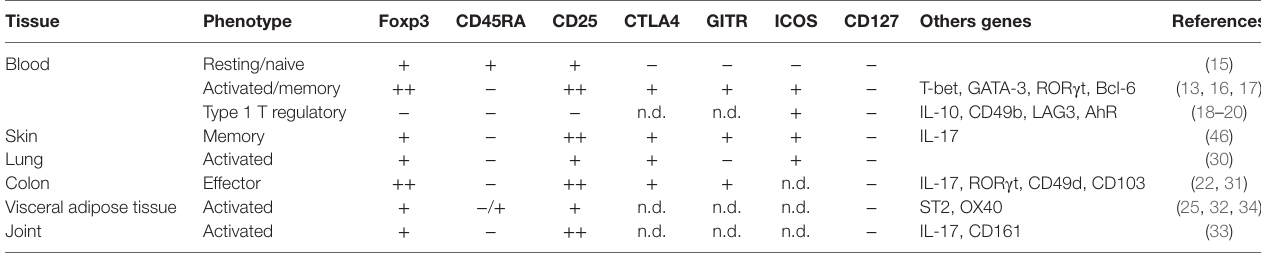
TabLe 1 | Genes and phenotypes of regulatory T cells detected in humans.